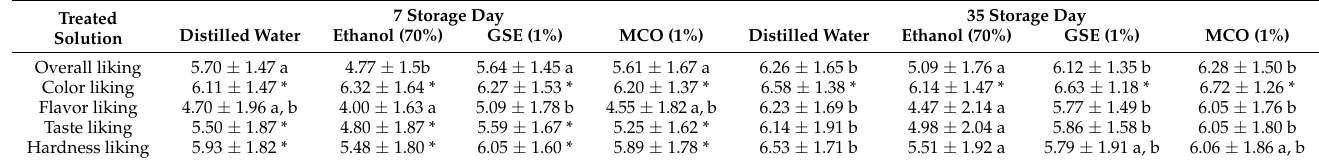
Table 3. Consumer acceptance test result of rice cake with different preservative agents. Treated